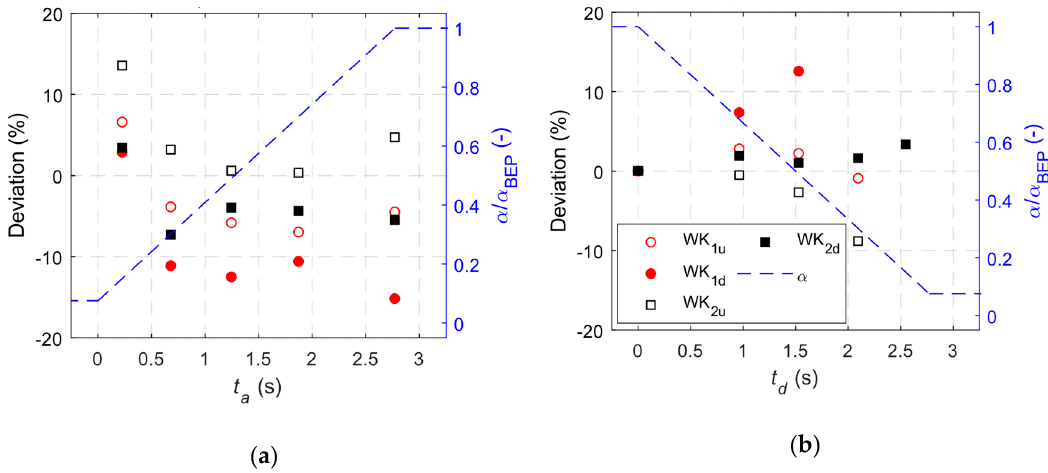
Figure 13. Deviation in the estimated flow rate and the transient flow rate obtained from the simulation with the WK configurations at θ = 101°, calculated using Equation (6). ( a ) Acceleration and ( b ) deceleration.